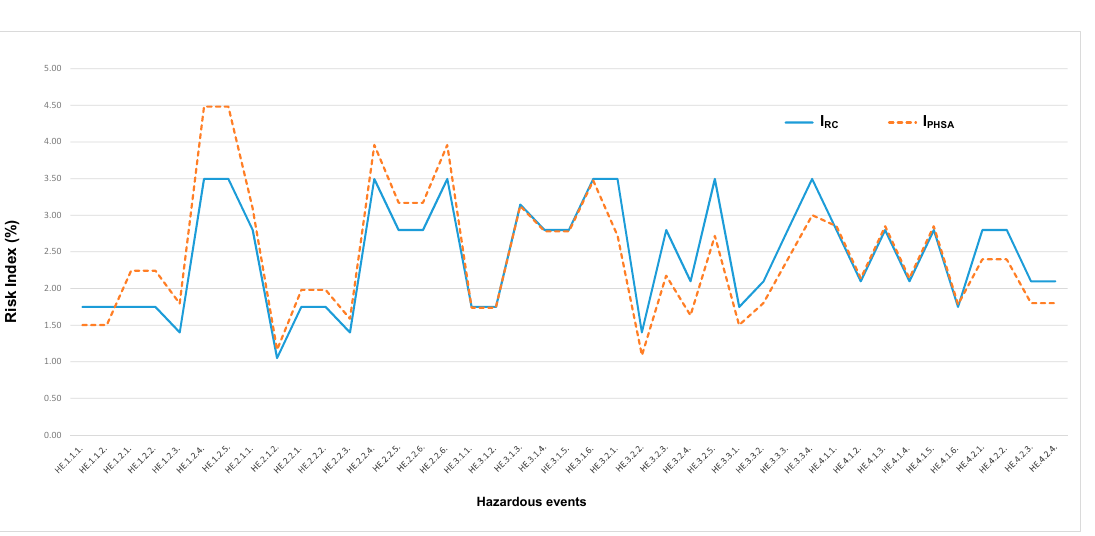
Figure 3. Comparison between the risk index considering the conventional (I RC ) and PHSA (I PHSA ) approaches.